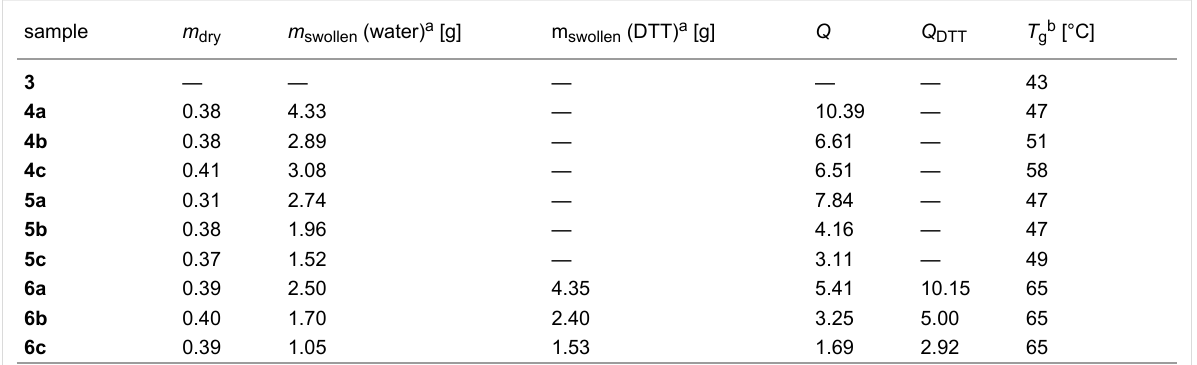
Compared to sample 5 , the swelling degrees of sample 4 are higher by about 2.5 to 3.5, depending on the amount of cross- linker used (Table 3). This can be explained by the structure of CL 1 which contains two amide groups and one disulfide func- tionality. Because of this polymer networks containing CL 1 can form more hydrogen bonds in contrast to networks containing CL 2 , and the enhanced affinity for interactions with water molecules leads to a better enclosure of water and there- fore a higher swelling degree. Sample 6 , which contains both cross-linkers, shows the lowest values for Q . This can be attri- buted to its overall higher content of cross-linker, compared to samples 4 and 5 . However, after immersion of 6a and 6b in 0.03 M DTT solution, and of 6c in 0.06 M DTT solution,